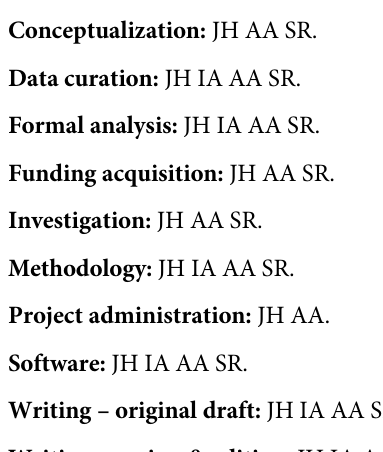
S1 Fig. Flow diagram of participant participation in the North RCT. S2 Fig. Flow diagram of participant participation in the South